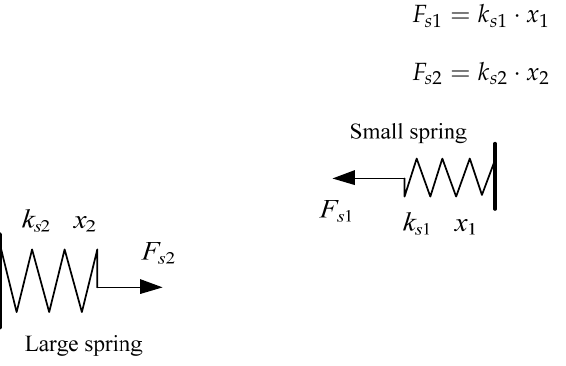
Figure 9. Mechanical model of springs.